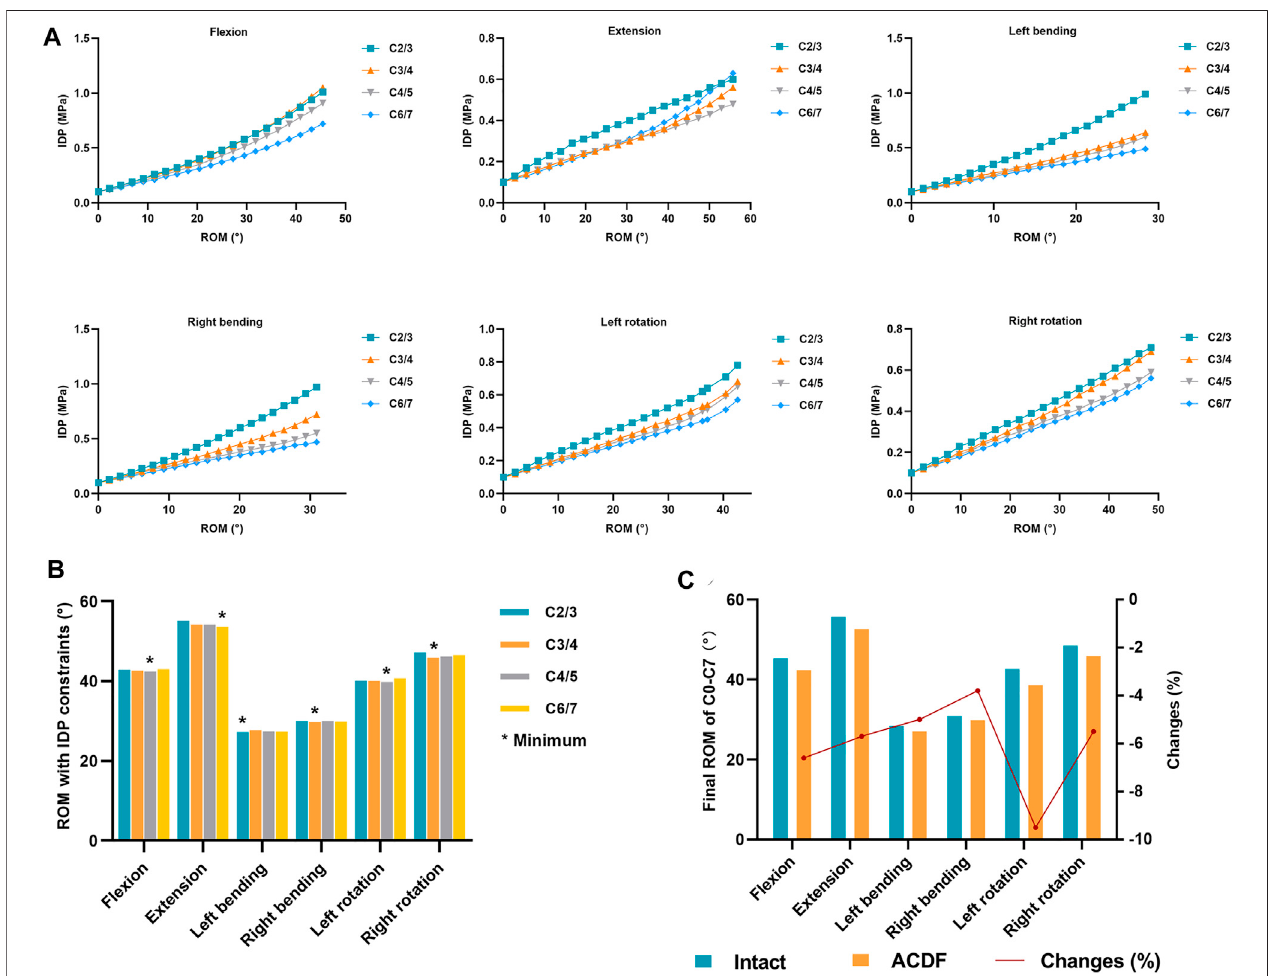
FIGURE6| ChangesofIDPofnon-fusedsegmentsintheACDFmodelwithincreasingtotalC0 – C7ROMandthe fi nalreasonabletotalC0 – C7ROMwascalculated (A) IDP values of C2/3, C3/4, C4/5, and C6/7 levels change with the increasing total C0 – C7 ROM in the ACDF model. (B) ROMs were calculated with IDP constraints in the ACDF model, and the minimum ROM in each motion direction was labeled*. (C) Reasonable total C0 – C7 ROM with FJF and IDP constraints was shown. Note: changes (%) = (ACDF model value — intact model value)/intact model value × 100%.